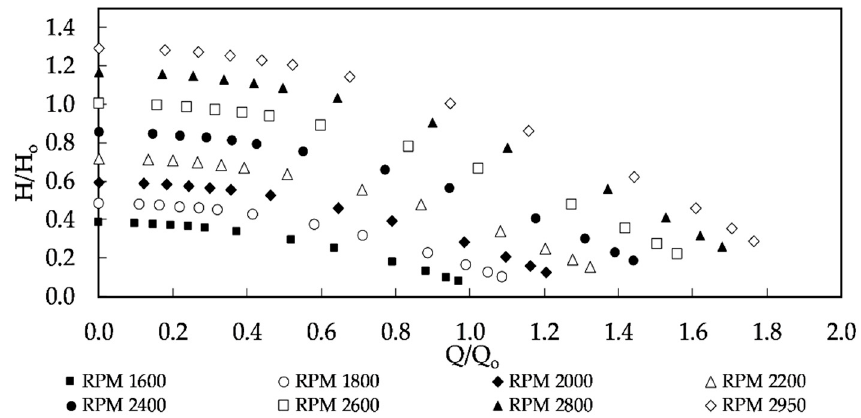
Figure 10. Dimensionless pump characteristic curves for different rotational speeds.